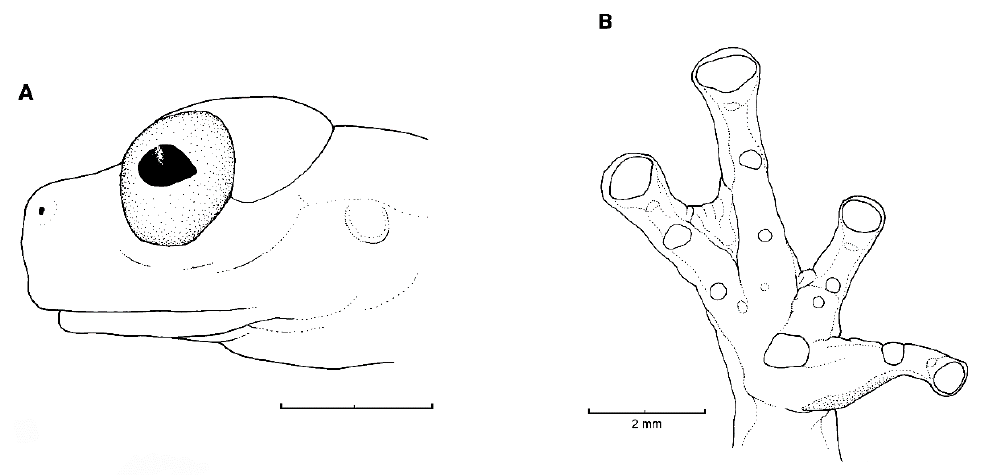
Figure 212. Teratohyla midas , QCAZ 33226. ( A ) Head in lateral view. ( B ) Hand in ventral view. Illustrations by Juan M. Guayasamin.